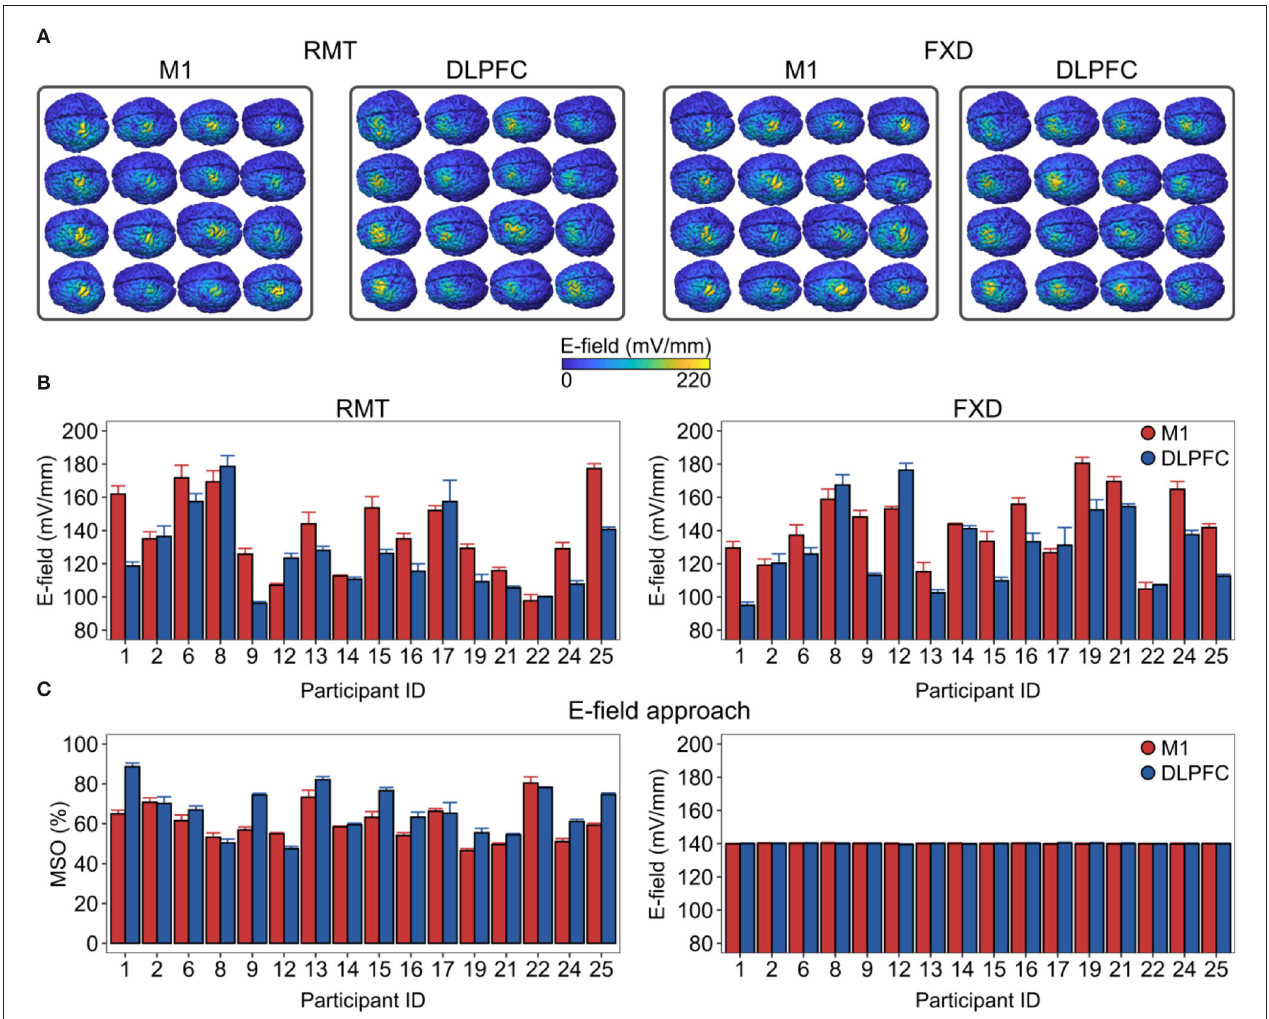
FIGURE 3 | Inter-individual variability in the macroscopic E-field is produced by the conventional intensity selection approaches and its reduction by a personalized intensity adjustment method. (A) The spatial distribution of E TOTAL over the cortical targets is shown for each individual. (B) There was substantial E-field variability in both conventional intensities. (C) We adjusted the stimulation intensities (left side) to produce closely matched macroscopic E-fields (right side) between cortical targets and across participants in the ROI. E-field values correspond to gray matter surface compartments. DLPFC, dorsolateral prefrontal cortex; FXD, fixed stimulation intensity; M1, primary motor cortex; MSO%, maximum stimulator output percentage; RMT, resting motor